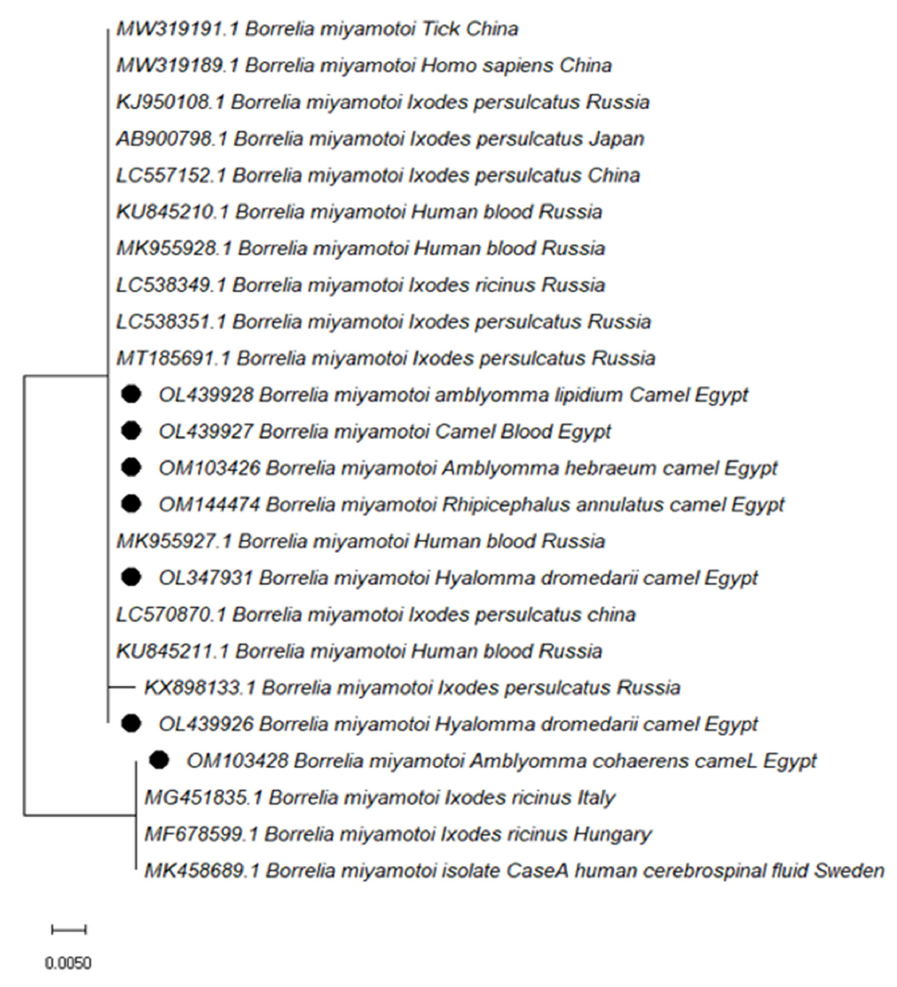
Figure 3. Phylogenetic relationships based on the glpQ gene sequences of B. miyamotoi the trees were constructed and analyzed using the Maximum Likelihood method. A black dot indicates the new sequences provided by the present study.